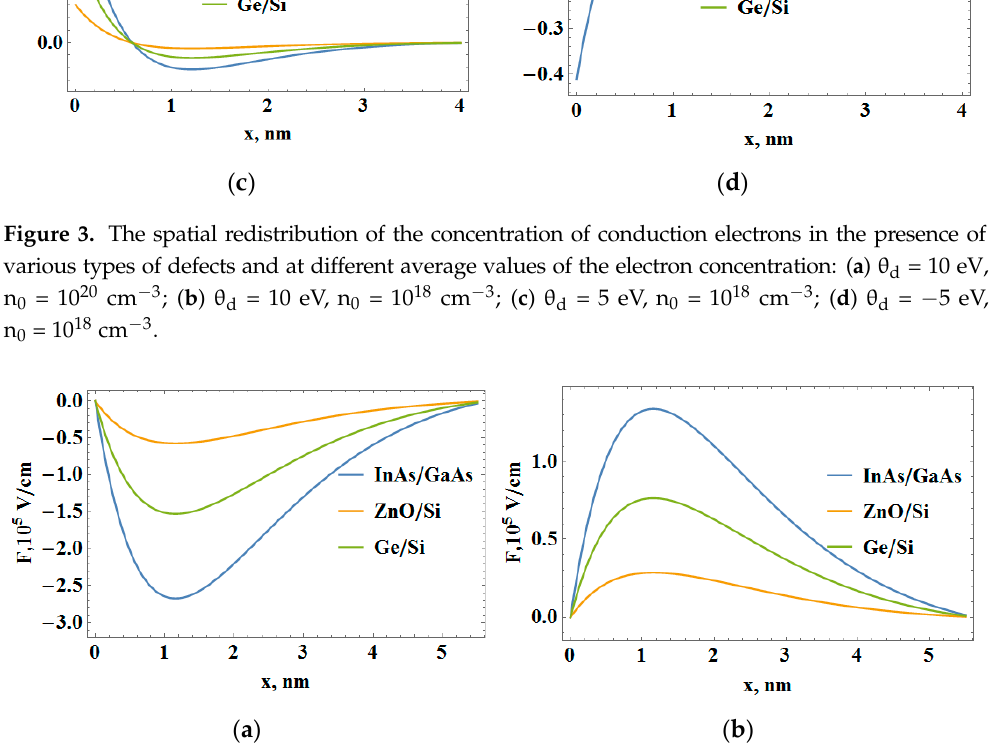
Figure 4. The coordinate dependence of the electric field in semiconductor film in the case of the presence of point defects: ( a ) the defects of the type of stretching centers ( θ d = 10 eV); ( b ) the defects of the type of compression centers ( θ d = − 5 eV).